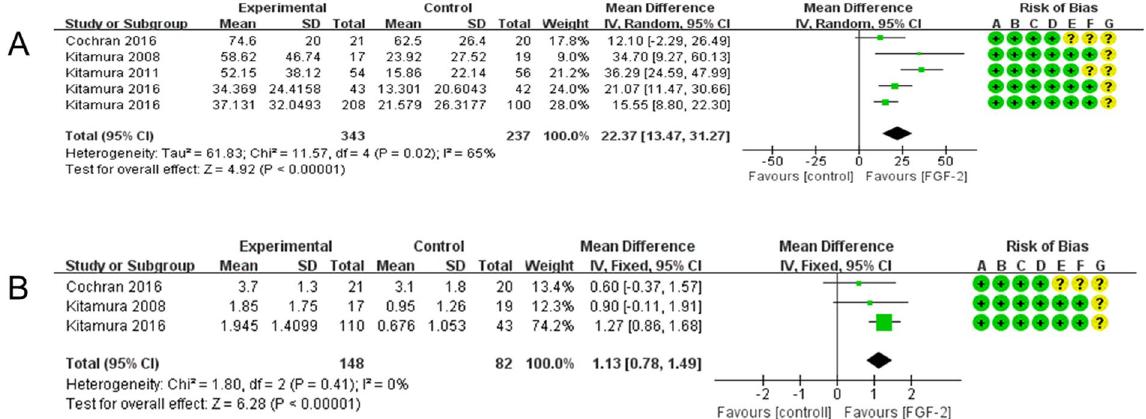
Figure 1. ( A ) Forest plot of comparison: 0.3% FGF2 groups was compared with control groups among patients with osseous defects, outcome: BF%. ( B ) Forest plot of comparison: 0.3% FGF2 groups was compared with control groups among patients with osseous defects, outcome: LBG. Risk of bias legends: (A) Random sequence generation (selection bias); (B) Allocation concealment (selection bias); (C) Blinding of particepants and